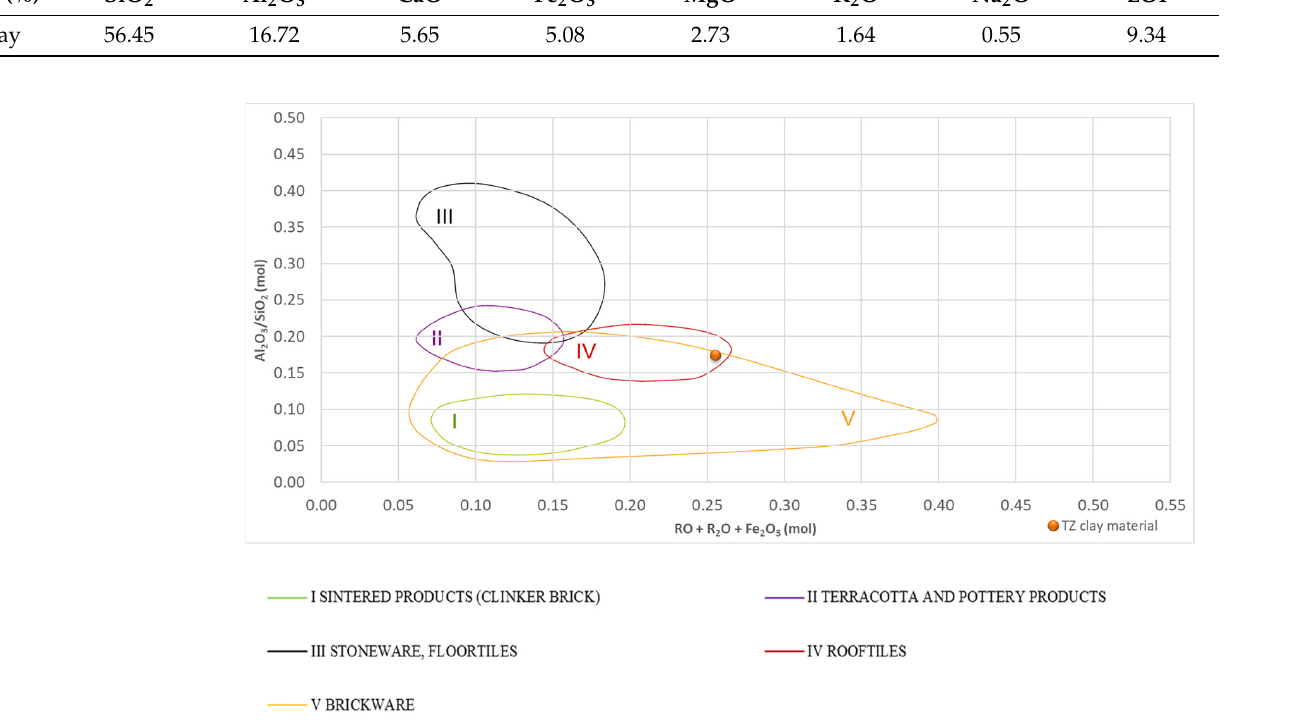
Figure 1. Suitability according to AVGUSTINIK of TZ clay [16].